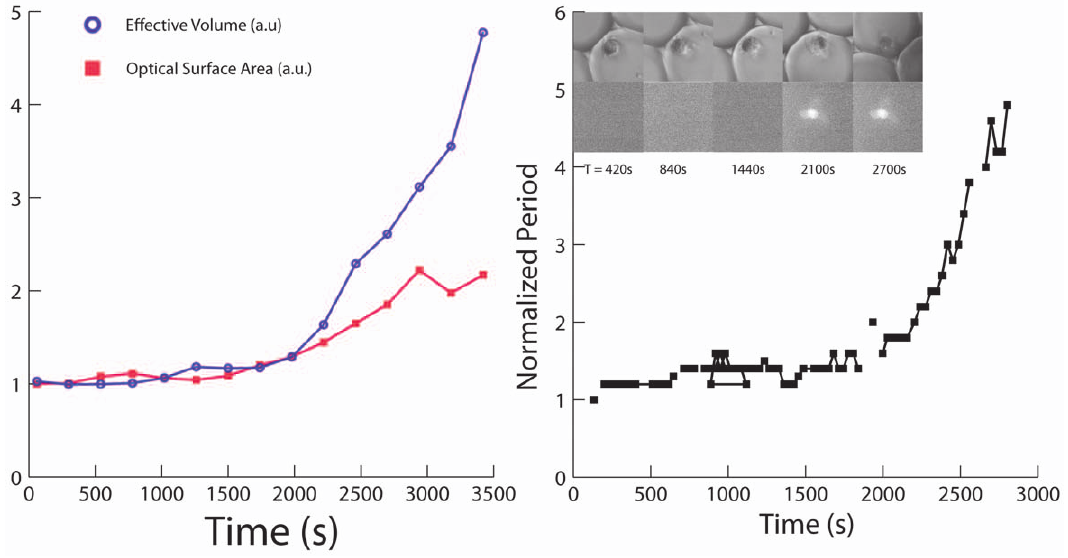
Figure 4. Sensitivity of the cell magneto-rotation method. a ) Comparison of sensitivities between microscope and magneto-rotation in measuring cell death (HeLa cell in DMEM, 5% Ethanol). In red is the normalized surface area as measured with the microscope, and in blue is the normalized effective volume period as measured with Magneto-Rotation using Supplementary Information S1 . b ) Comparison of cell death monitoring using magneto-rotation and Live/Dead cell assay.